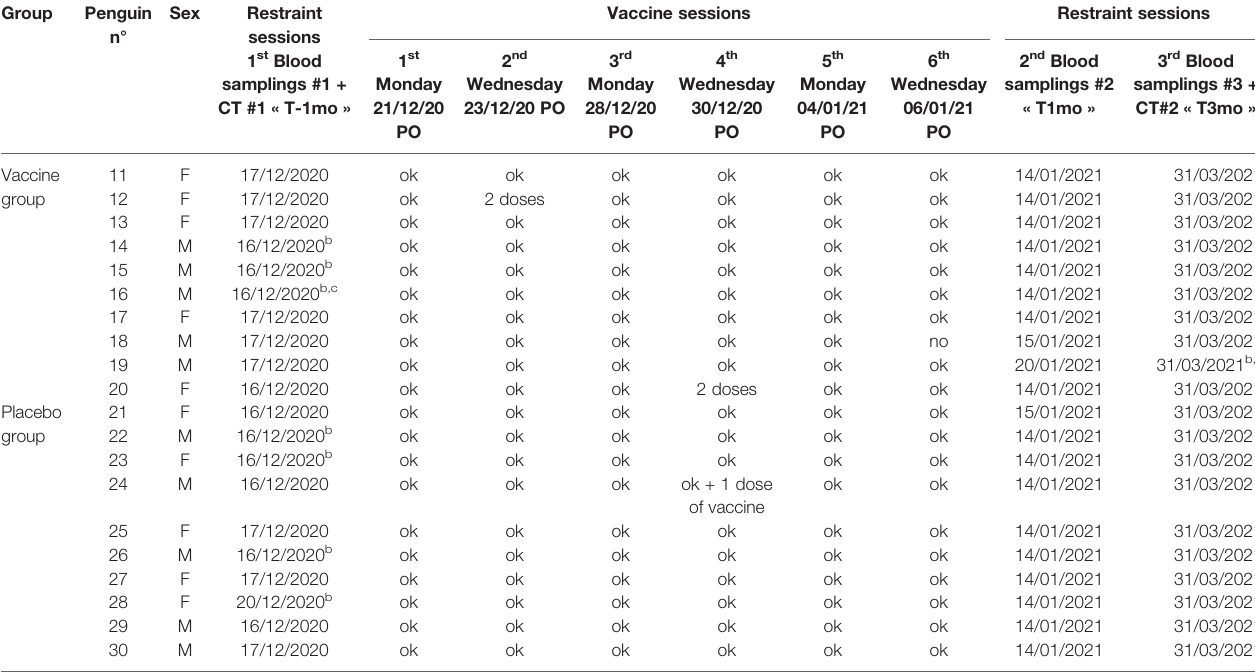
TABLE 1 | Penguins and procedures in the vaccination trial a . Group Penguin n°